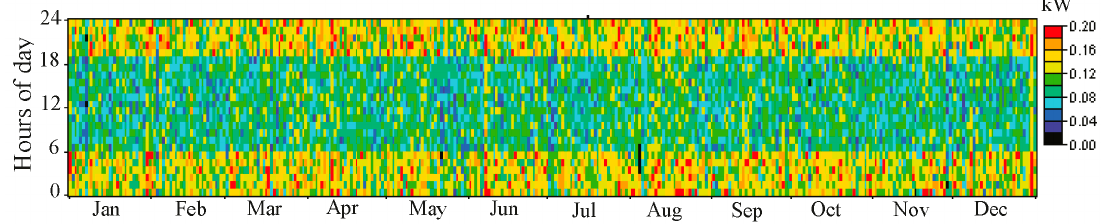
Figure 17. Monthly statistics of the inverter output power.